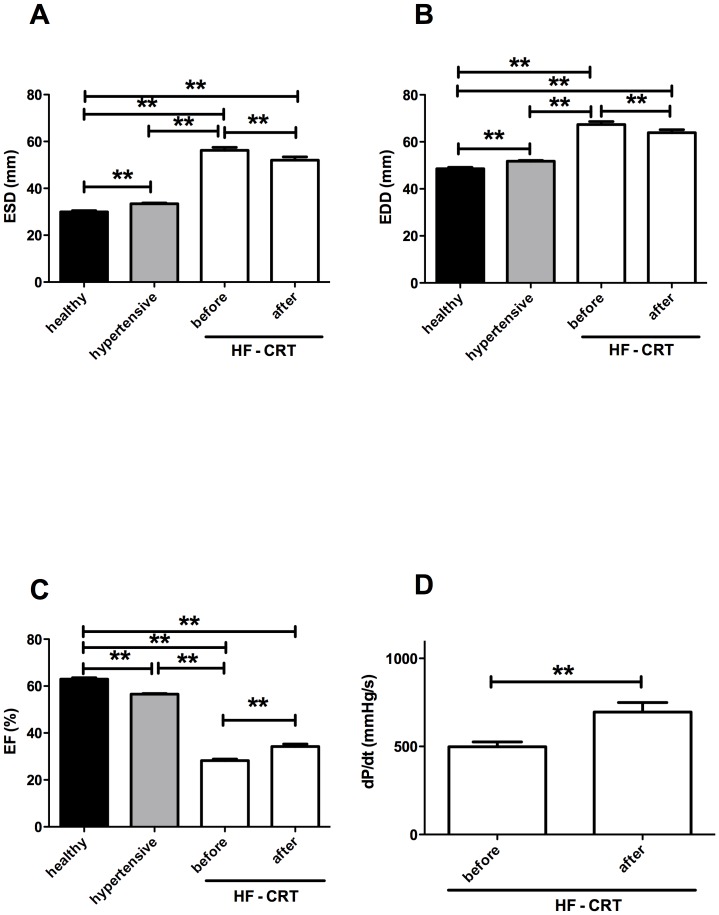
Echocardiographic parameters of the study populations.Left ventricular echocardiographic parameters end systolic diameter (ESD, panel A), end diastolic diameter (EDD, panel B) and ejection fraction (EF, panel C) are shown in healthy people (healthy, n = 45, filled bars), patients with hypertension (hypertensive, n = 239, grey bars) and with severe heart failure (HF - CRT, n = 65, open bars). The kinetics of ventricular contractions (dP/dt) is shown in patients with severe heart failure (panel D, n = 22). Values in patients undergoing cardiac resynchronization therapy are shown before device implantation (HF - CRT, before) and after 6–9 months (HF - CRT, after). Unpaired echocardiographic values were analyzed by the nonparametric Kruskal-Wallis test (two tails, panel A–C). Paired echocardiographic data (CRT before and after, panel A–C and dP/dt, panel D) were evaluated by the nonparametric Wilcoxon matched-pairs signed rank test (two tails). Bars are mean ± S.E.M. Significant differences are labeled by asterisks (** P<0.001).